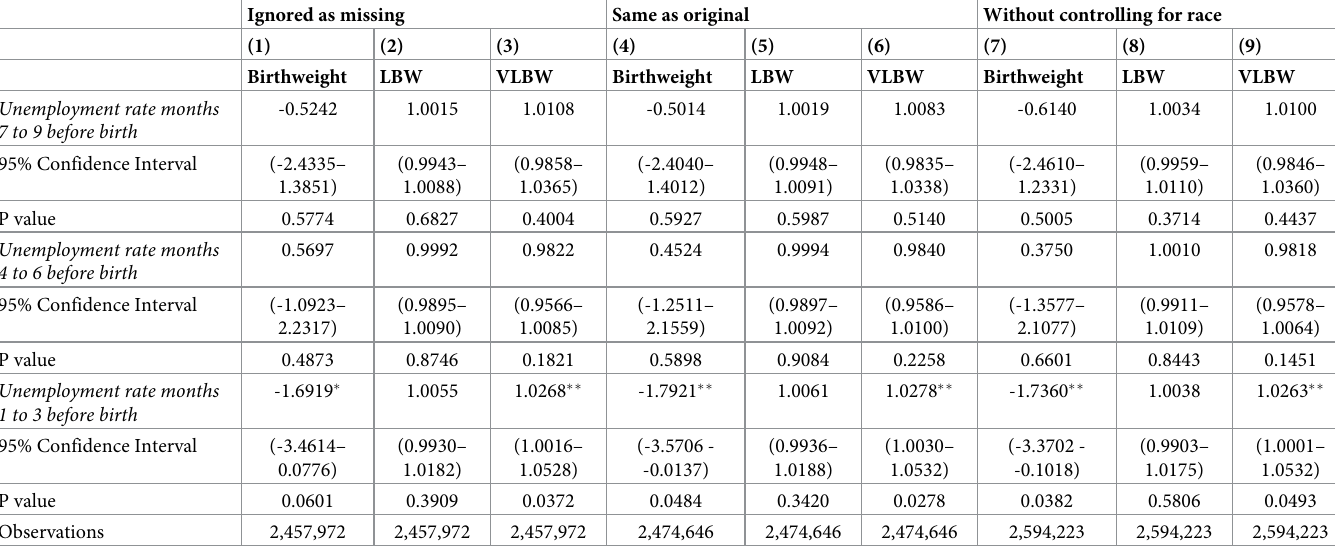
Table 3. Unemployment rate at the mother city of residence and birth outcomes, robustness checks. Ignored as missing Same as original Without controlling for